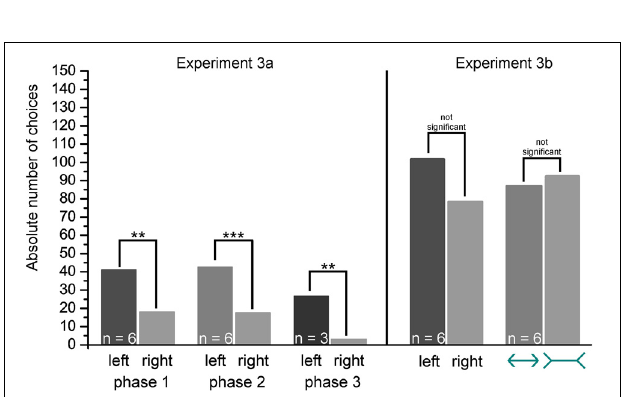
FIGURE 11 | Size pairs and Müller-Lyer deception. Shown are the group results of the transfer test trials. p > 0 . 05 not significant, p ≤ 0 . 01 highly significant ( ∗∗ ), p ≤ 0 . 001 significant ( ∗∗∗ ). The correct choice is marked by a